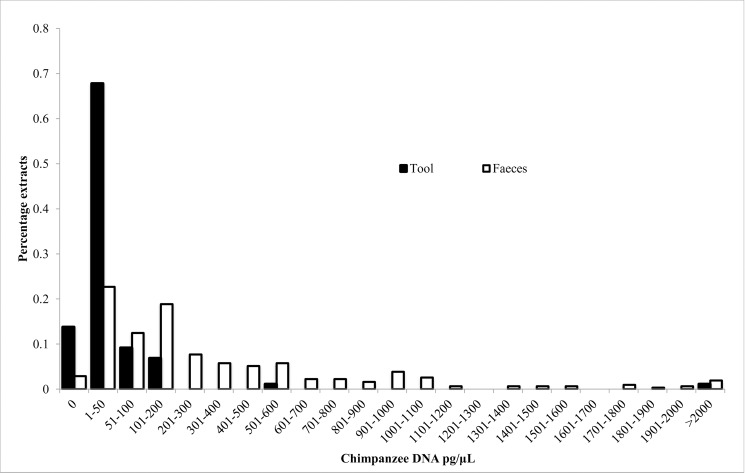
Histogram comparing chimpanzee DNA concentration of termite-fishing tool and faeces DNA extracts.